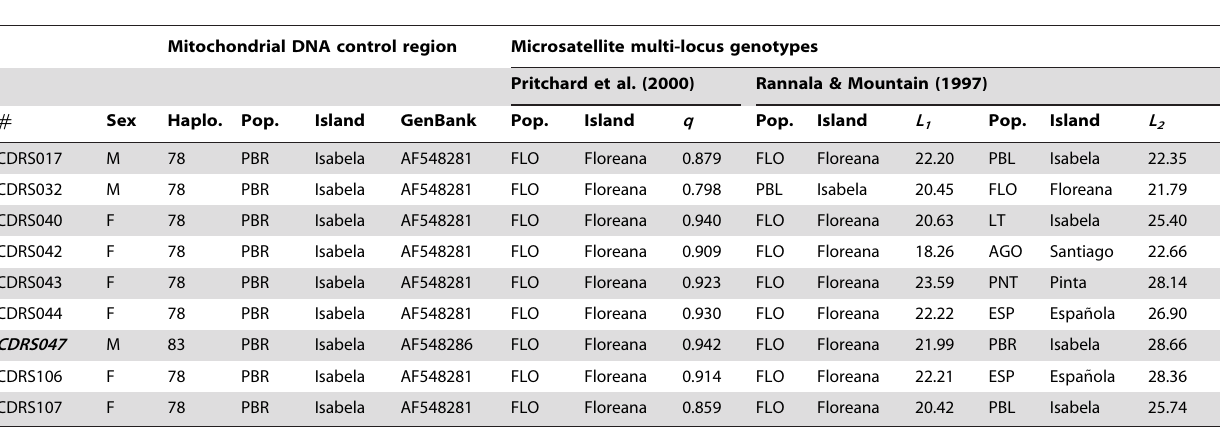
Table 1. Captive Gala´pagos tortoises of unknown origin with signatures of Floreana